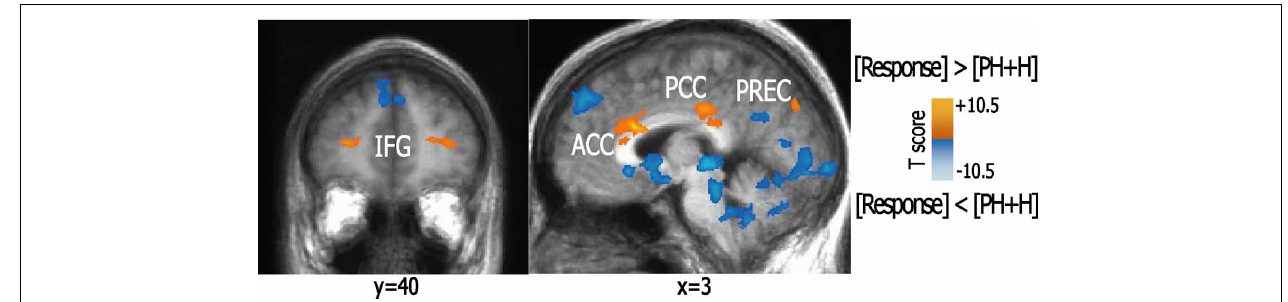
Statistical parametric maps ( p < 0 . 01 corrected) of activations are visualized on a brain template. Abbreviations: IFG, inferior frontal